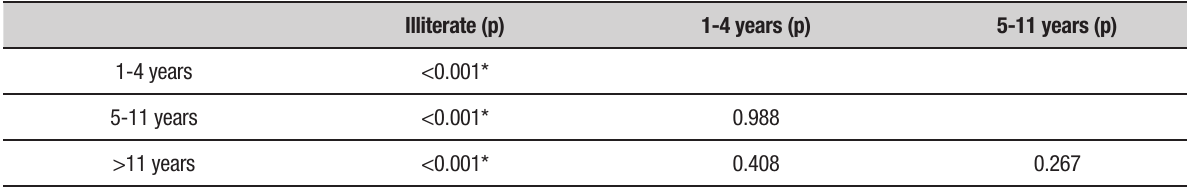
Figure 1. CDT scores for the groups investigated. Confidence interval for mean: mean ± 1.96. *standard-deviations / √ (n-1).